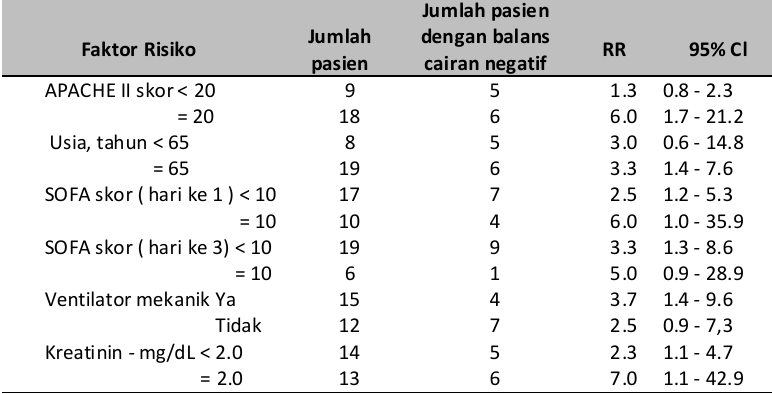
Table 3. Perbandingan Rasio Risiko (RR) kelompok survivor dibandingkan